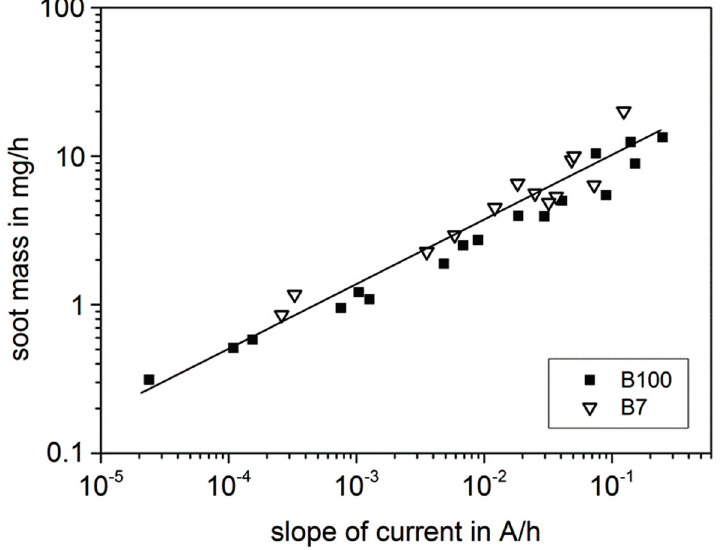
Figure 6. Correlation between evaluated sensor data and achieved particle mass per